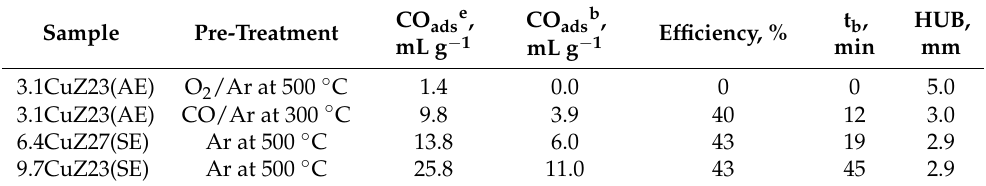
Table 4. Data from CO breakthrough measurements for different Cu/ZSM-5 samples. The capacity at full saturation is denoted by CO adse and the working capacity, by CO adsb